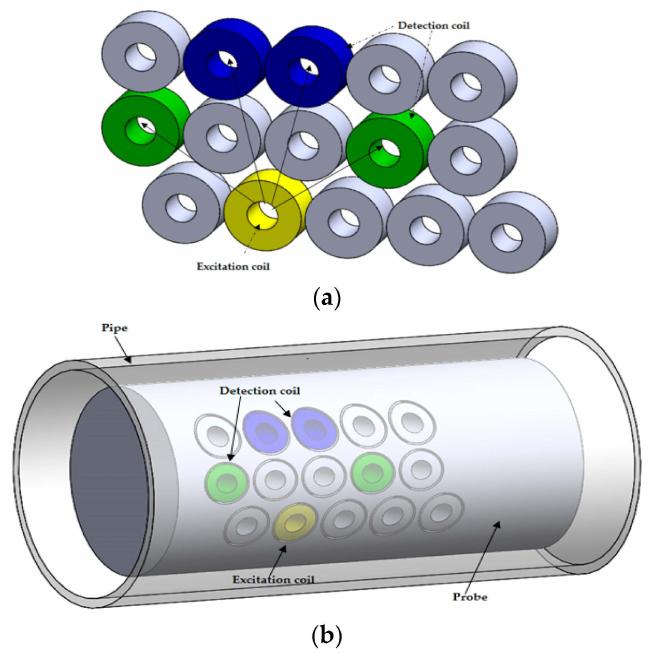
Figure 9. Smart array probe: ( a ) Excitation and detection coil configuration; ( b ) illustration of the excitation and detection coil location on the eddy current testing probe for a smart array